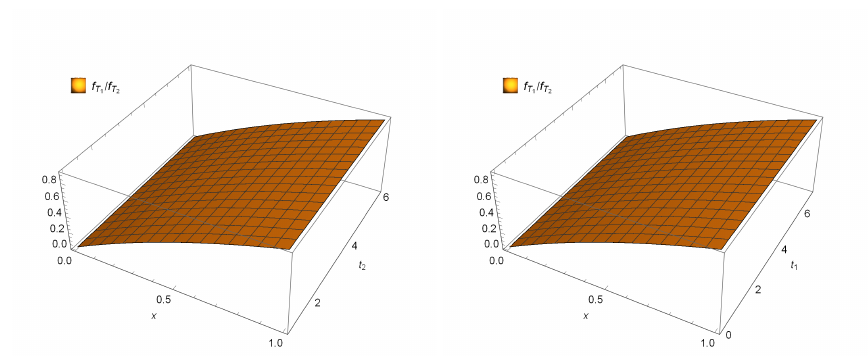
; x )) / ( F ( RX T 2 ; x )) , for the t 1 = 1 ( left ) and t 2 = 8 ( right ). 4:4 4:4